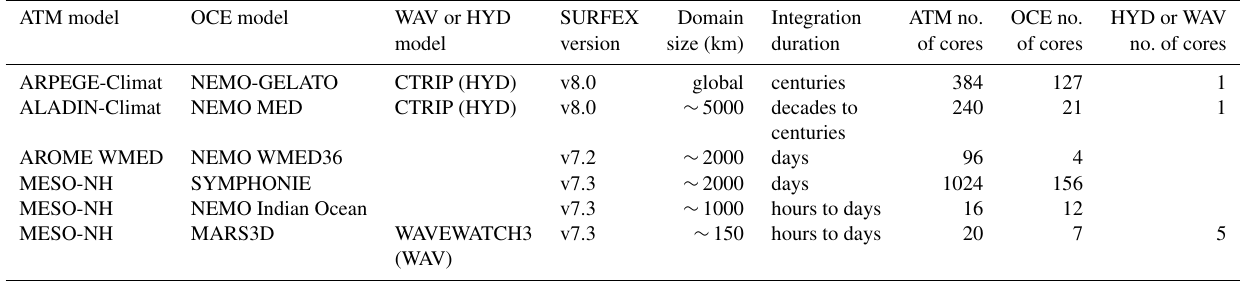
Table 2. List of model configurations implemented, with their domain size and their computational balance. ATM